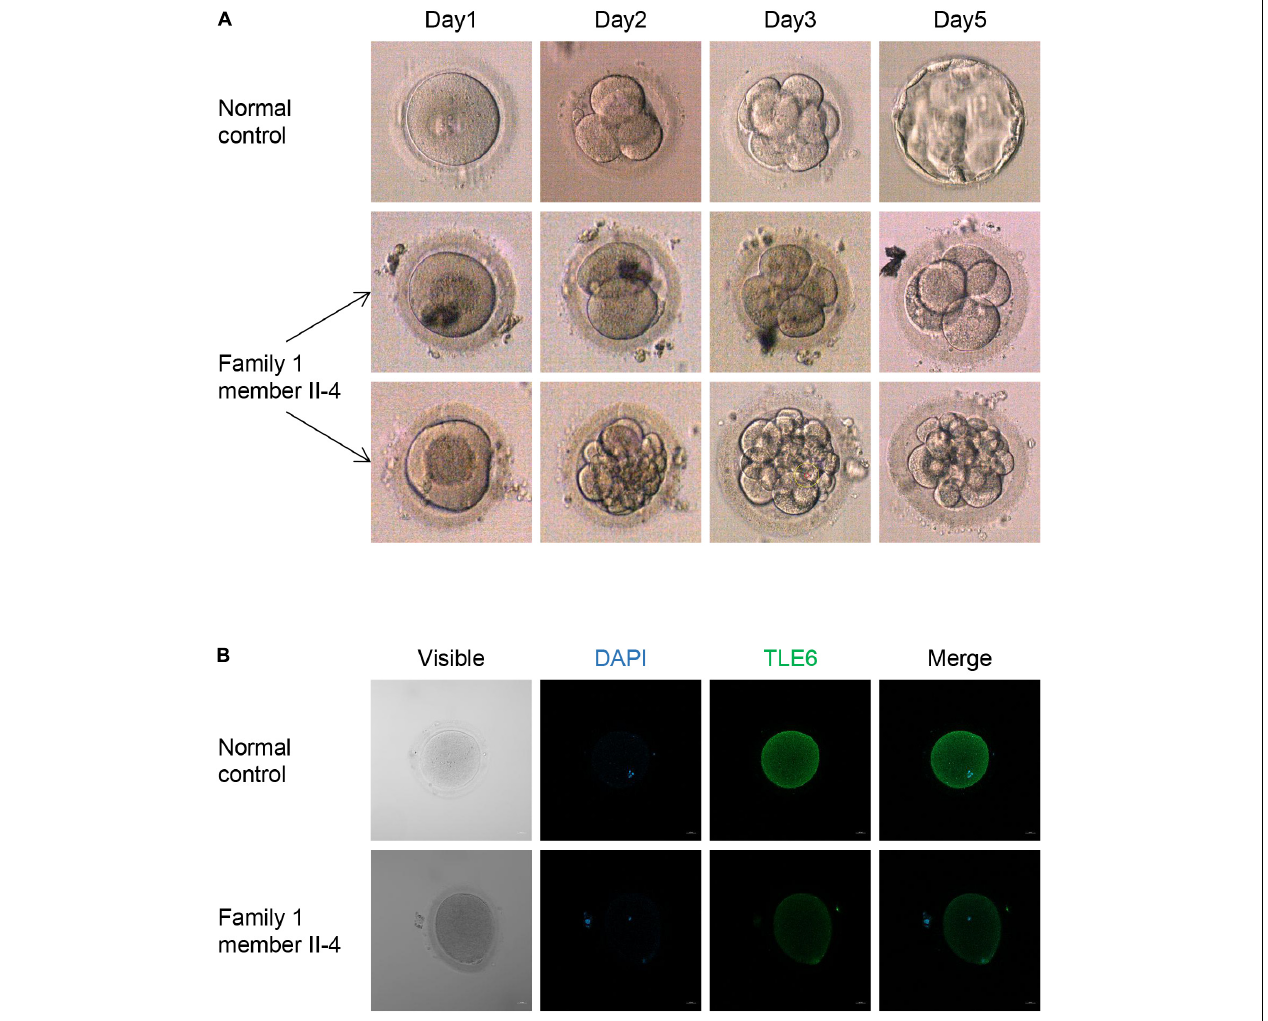
FIGURE 2 | Phenotypes of embryos and oocytes from control and patients. (A) Phenotype of control embryos from a subject underwent the ICSI attempt owing to male infertility and embryos from the patient II-4 in family 1. The light microscope was used to observe the morphologies of embryos on days 1, 2, 3, and 5 during cultivation. (B) The morphologies and immunofluorescence staining results of an oocyte from the patient II-4 in family 1 and a normal oocyte from a control individual. Oocytes were stained with DAPI (blue) in order to visualize the DNA and immunolabeled with antibodies against TLE6 (green). Scale bar, 20 µ